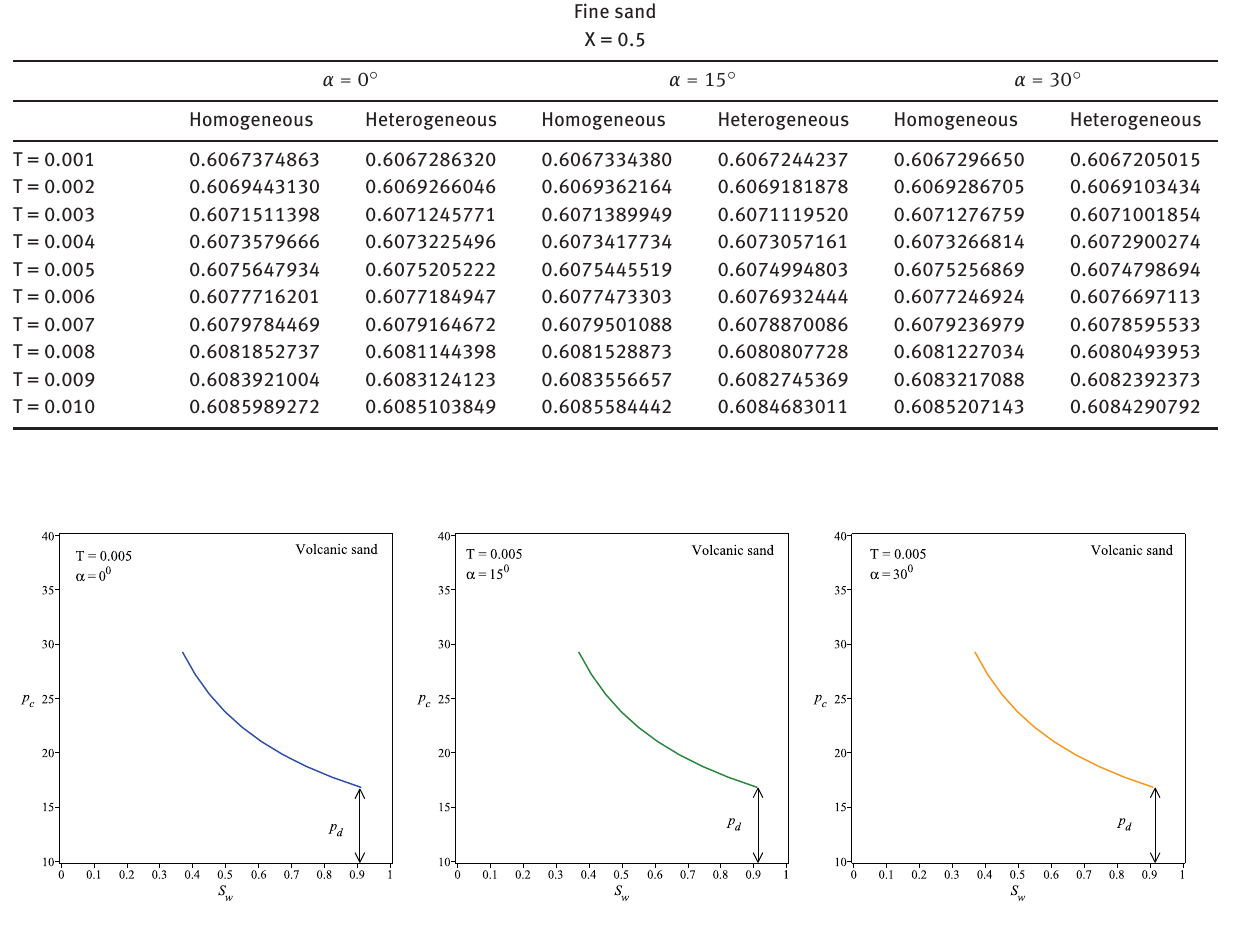
Fig. 6: Capillary pressure vs. Saturation in Heterogeneous Porous Media for Volcanic Sand at different inclined plane α = 0 ◦ , 15 ◦ , 30 ◦ .